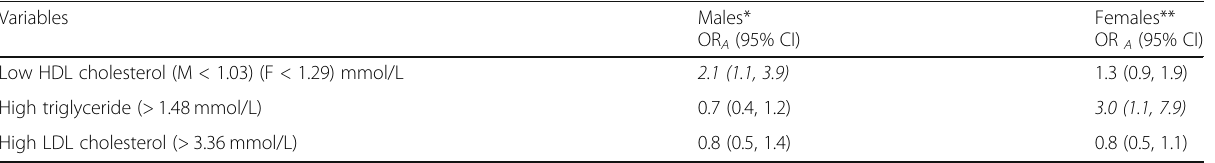
Table 4 Multivariate model showing the independent association of lipid panels with standardized vitamin 25(OH)D levels in Saudi males and females in Riyadh, Saudi Arabia